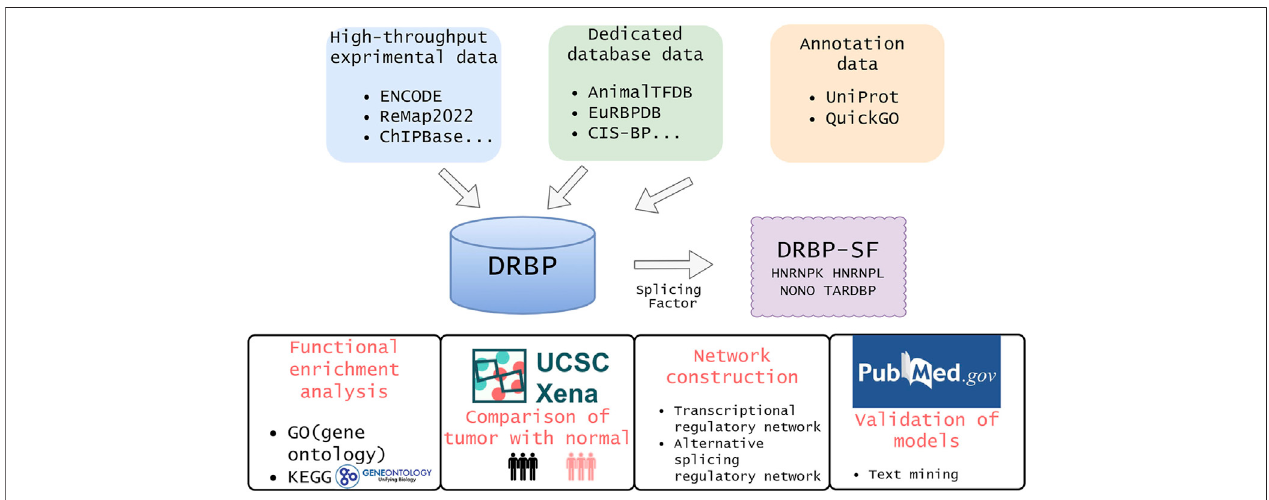
FIGURE 1 | Overview of this study. We collected DRBPs from high-throughput, dedicated database, and annotation data. Then, the intersection of DRBP and splicing factor lists are de fi ned as DRBP-SFs. To investigate the functions of DRBP-SFs, we carried out differential expression analysis, functional enrichment analysis and network construction for HNRNPK, HNRNPL, NONO and TARDBP in chronic myeloid leukemia. At last, we veri fi ed the model by text mining.